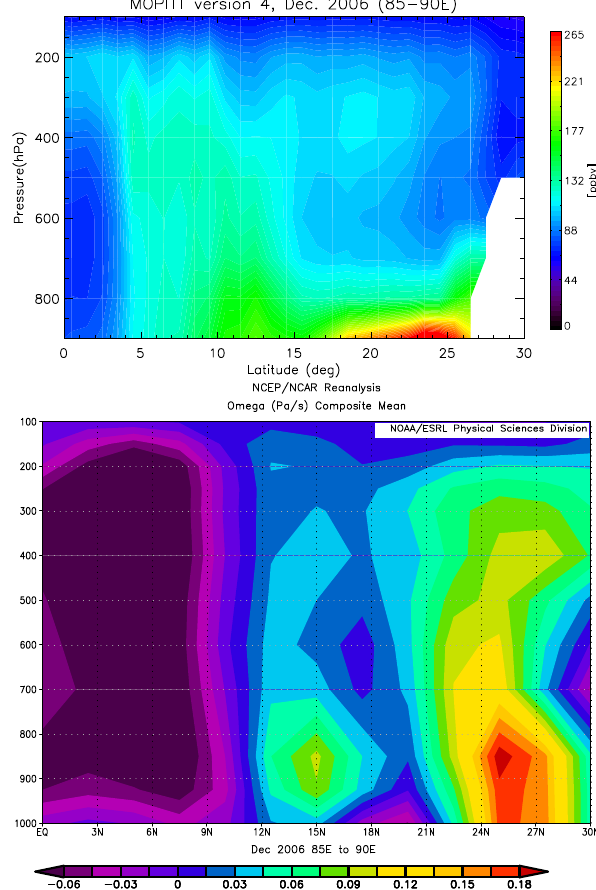
Fig. 4. (a) (top) Pressure-Latitude cross section of CO mixing ratios retrieved from MOPITT version 4 along 85 ◦ E–90 ◦ E. (b) (bottom) Pressure-Latitude cross section of omega (Pa/s) along 85 ◦ E–90 ◦ E from NCEP reanalyses for December 2006. Image provided by the NOAA/ESRL Physical Sciences Division, Boulder Colorado from their Web site at